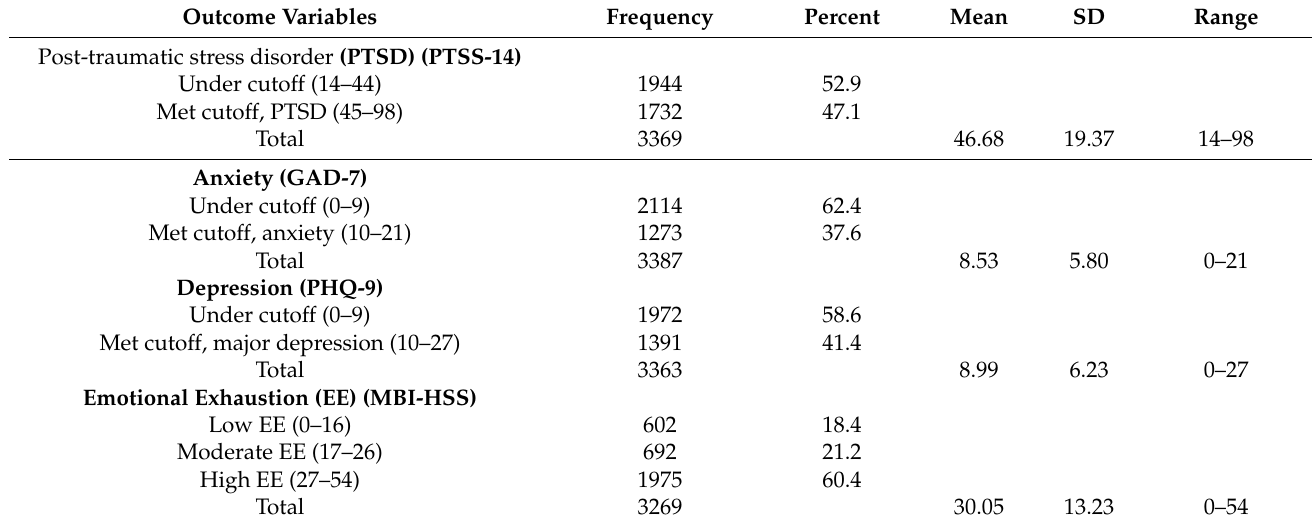
Table 3. Descriptive statistics for mental health outcomes and proportions for cutoff